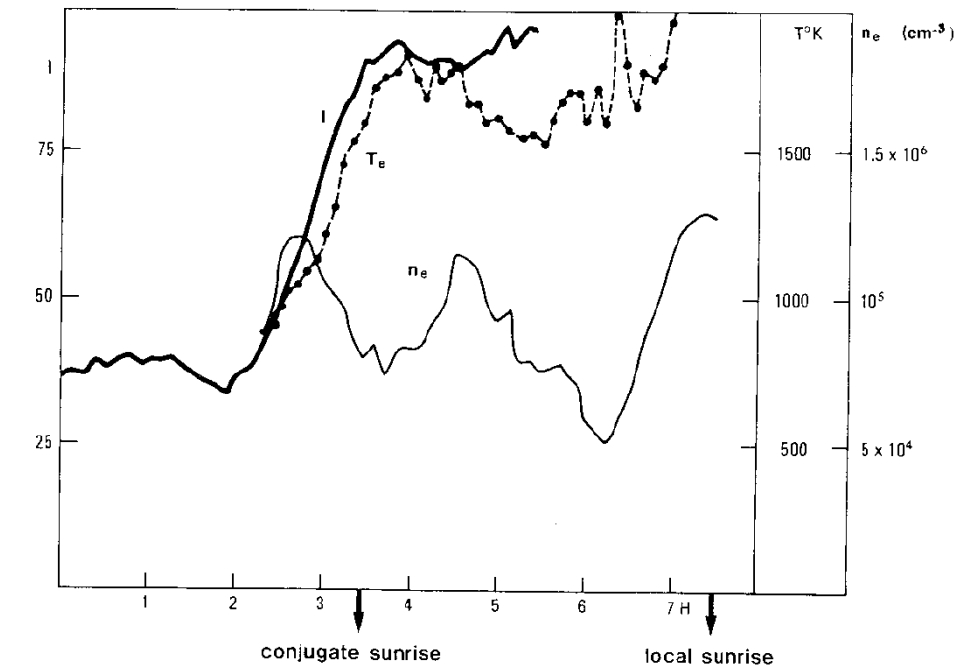
Figure 3. Simultaneous measurements of the oxygen line (I in Raleigh), of the electron temperature ( T e in ◦ K) and of the electron concen- tration ( n e in cm − 3 ) (Duboin et al.,